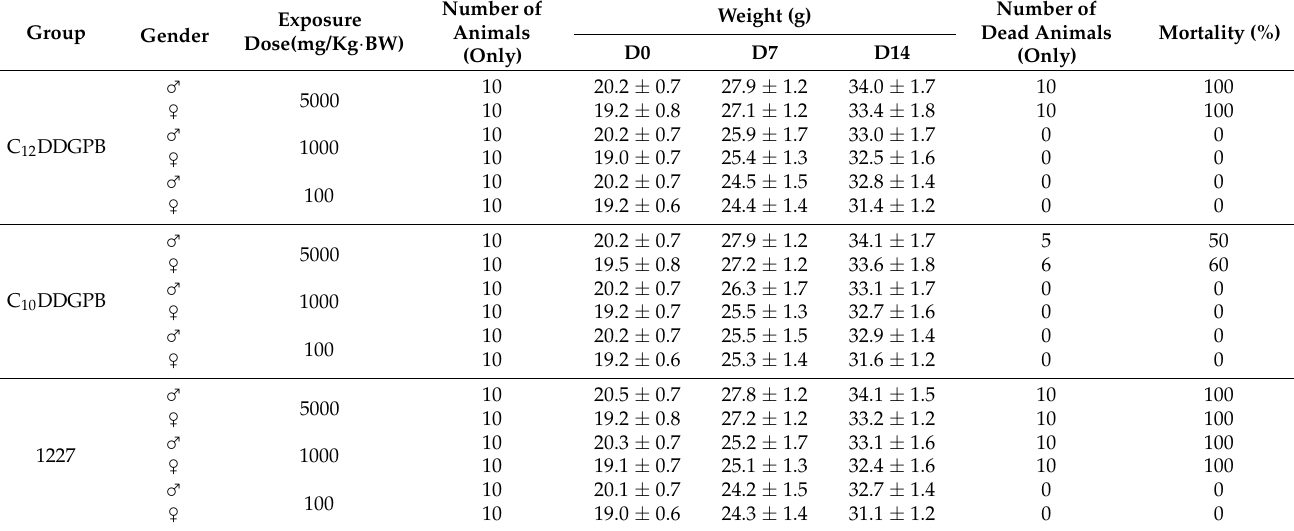
Table 3. Results of acute oral toxicity